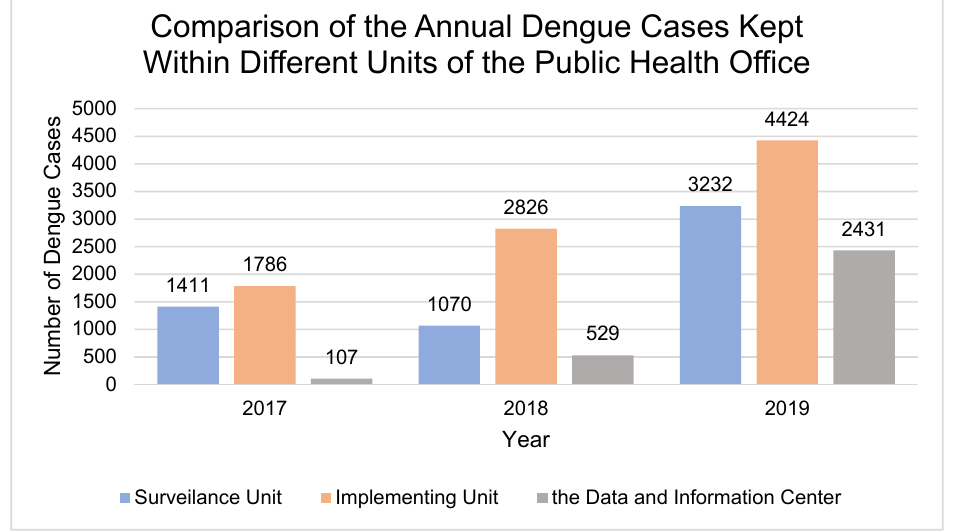
Figure 4. Comparison of annual dengue cases recorded by different units of the Public Health Office in 2017–2019. The implementing unit always records the highest number of cases while the Data and Information Center consistently records the least.